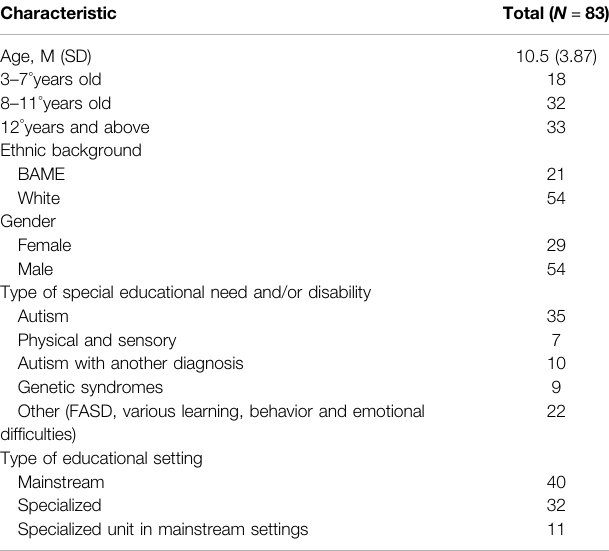
TABLE 1 | Characteristics of children whose parents responded to the